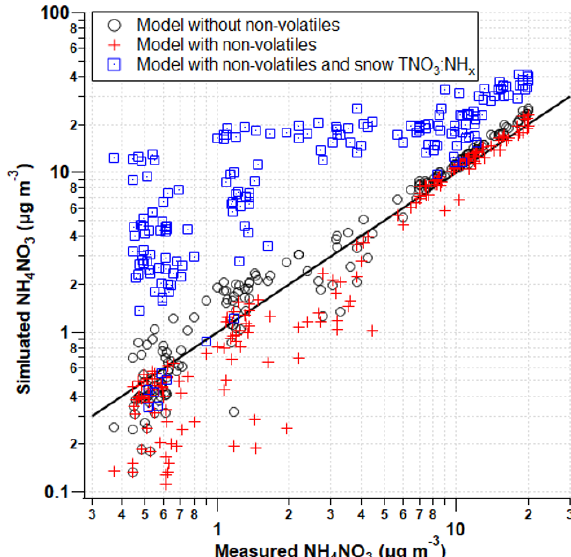
Figure 8. Predicted concentrations (ISORROPIA) with respected to measured (AIM-IC) ambient concentrations of NH 4 NO 3 in µgm − 3 through the second pollution event from 13 to 19 February 2017. The model was run in three separate conditions: (1) with (red cross) and (2) without (open black circle) the addition of p K + , p Ca 2 + , and p Mg 2 + and (3) with non-volatiles and the increase in total ni- trate based on the ratio of NH + to NO − measured in the 4 3